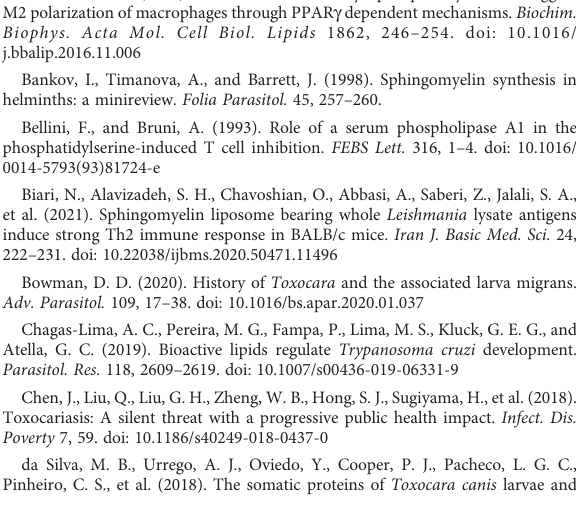
SUPPLEMENTARY FIGURE 1 The BPC (base peak chromatograms) overlapping spectrum of QC samples in positive ion mode (ESI + ) (A) and negative ion mode (ESI − ) (B) . SUPPLEMENTARY FIGURE 2 The coef fi cient of variation (CV) and principal component analysis (PCA) of QC samples. (A) The CV plot of QC samples. The two lines perpendicular to the X-axis represent 20% and 30% CV reference lines, respectively, andthelineparallel tothe X-axisdenotes60%referenceline. (B) The PCA score scatter plots of lipids in QC of infected (I) and control (C) samples. AG, A group; BG, B group; CG, C group. SUPPLEMENTARY FIGURE 3 Total ion chromatography data show minor changes in the relative lipid abundance between the infected group (I) and control group (C) at 12 hpi (A – D) , 24 hpi (E – H) , and 36 dpi (I – L) in positive ion mode (ESI + ) and negative ion mode (ESI − ). SUPPLEMENTARY FIGURE 4 The principal component analysis (PCA) score scatter plots of lipids in beagle dogs infected with 300 Toxocara canis eggs. ( A – C ) represent PCA score plots of the infected groups (I) and control groups (C) at 12 hpi, 24 hpi, and 36 dpi, respectively. AG, A group; BG, B group; CG, C group. SUPPLEMENTARY FIGURE 5 The changes of lipid subclasses between the infected group (I) and control group (C) at 12 hpi, 24 hpi, and 36 dpi, respectively, by Student ’ s t -test using SPSS 19. * p < 0.05, ** p < 0.01, *** p < 0.001. SUPPLEMENTARY FIGURE 6 Heatmaps and hierarchical clustering of the lipid species with differential abundance between the infected groups (I) and control groups (C) at 12 hpi (A) , 24 hpi (B) , and 36 dpi (C) . The dendrograms at the top of the heatmaps represent the relationship between the different infected and control samples. The dendrogram at the left of the heatmaps represents the phylogenetic relationship between the lipid